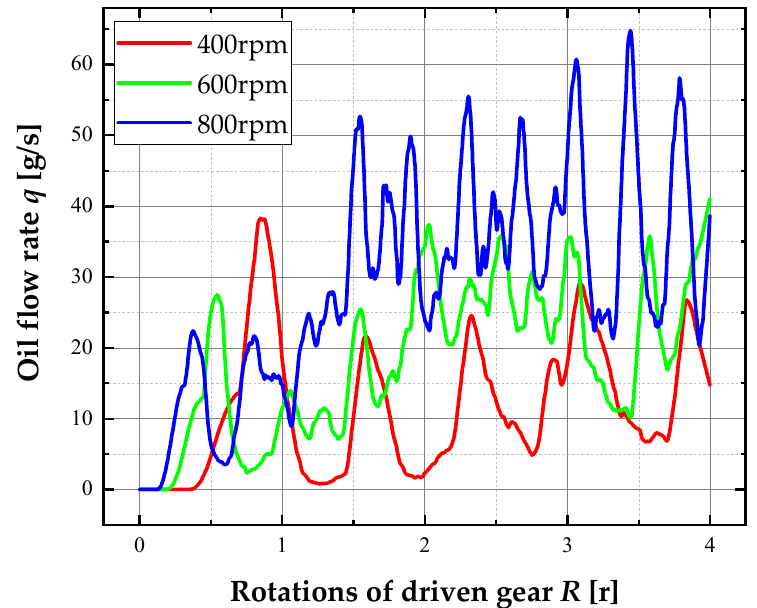
Figure 12. Oil flow rate of the meshing area at various rotation speeds. The amount of lubricating oil that flows through the gear-meshing area under the action of the oil-guiding tube can be seen in Figure 13, and it varies according to the depth of oil immersion. The mean flow rates of l = 40 mm, 45 mL, and 50 mm are 16.4 g/s, 18.4 g/s, and 34.4 g/s. The lubricating oil flow rate of the gear-meshing area l = 45 mm is slightly higher than l = 40 mm. However, the lubricating oil flow rate of the gear-meshing area at l = 50 mm is abnormally increased compared to l = 45 mm. Combined with the previous verification test, it can be learned that due to the increase in the oil-immersion depth, a huge quantity of lubricating oil rises to the gear surface along the inner wall of the gearbox under the action of centrifugal force. As a result, the abnormal increase in the lubricating oil flow rate in the gear-meshing area has nothing to do with the drainage function of the guide tube. Therefore, it is possible to draw the conclusion that raising the oil-immersion depth within a particular range can result in a modest improvement in the drainage effect produced by the oil-guiding tube. On the other hand, excessive oil immersion will cause a significant quantity of lubricating oil to climb to the surface of the gear, which will in- crease the churning power loss. This is a situation that must be avoided.